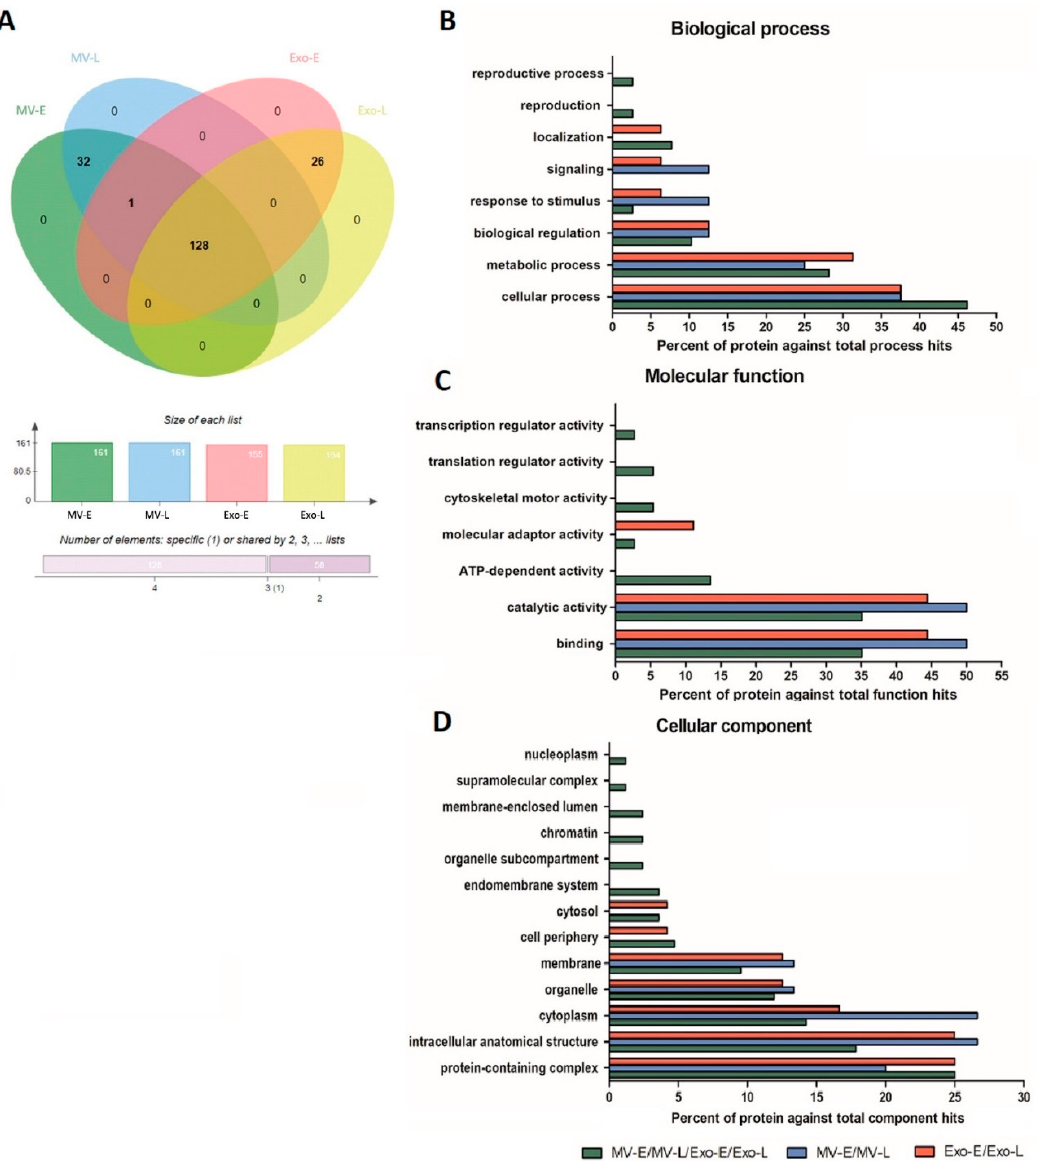
Figure 4. P. falciparum proteins in different types of Pf -EVs and stages of development (MV-E, MV-L, Exo-E, and Exo-L). ( A ) Venn diagram showed the proteins differentially expressed in each type of Pf -EVs. The column graph presents the number of proteins in each type of EVs, and the bar graph indicates the number of proteins shared between the type of EVs. (B–D) GO annotation analysis of the proteins common to EVs (MV-E/MV-L/Exo-E/Exo-L), MV (MV-E/MV-L), and Exo (Exo-E/Exo-L); ( B ) biological process, ( C ) molecular function, and ( D ) cellular component.